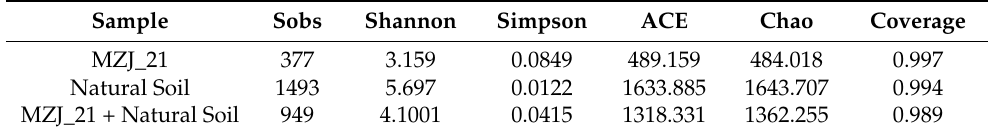
Table 2. Alpha diversity index.